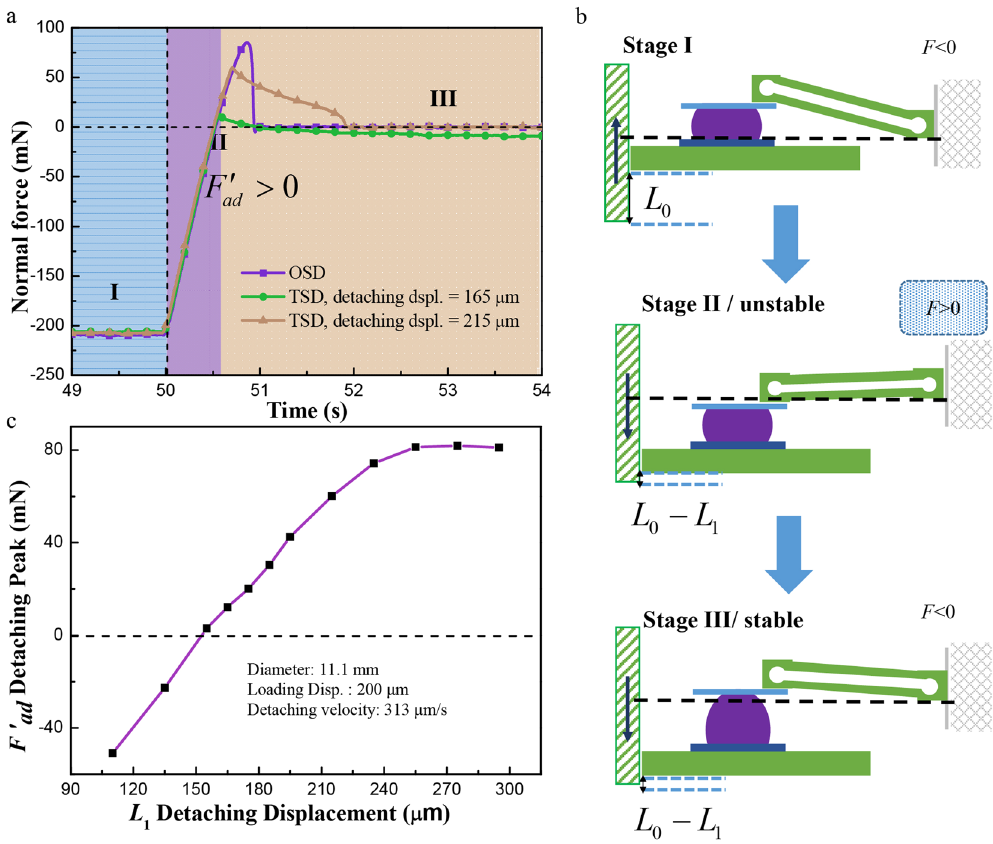
Figure 2. Procedure of the first detaching peak in TSD. ( a ) Normal force vs. time curve of OSD and TSD for a sphere diameter of 11.1 mm, the detaching velocity of 313 μ m/s, L 0 = 200 μ m, L 1 = 165 or 215 μ m; ( b ) Sketch of the deformation procedure around the transient adhesion force peak; ( c ) F ′ ad vs. detaching displacement for a sphere diameter of 11.1 mm, the detaching velocity of 313 μ m/s and a loading displacement of 200 μ